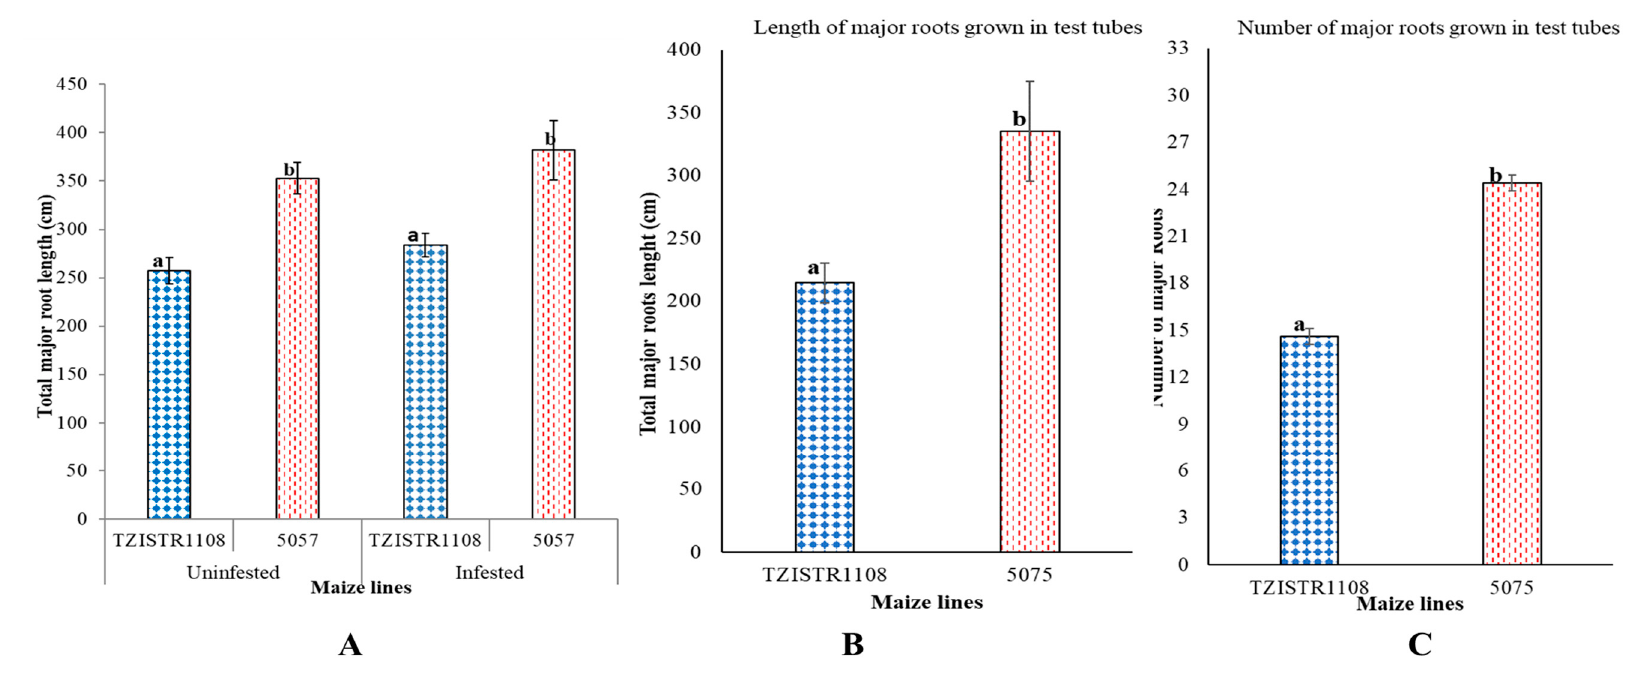
Figure 3. Root architecture evaluation. ( A ). Mean total length of major roots (infested and un ‐ infested) on both maize lines at 28 days after planting in pots. ( B ). Mean number of major roots at 53 days after planting in test tubes. ( C ). Mean total length of major roots at 53 days after planting in test tubes. The different letters (a and b) show significant differences among groups ( α = 0.05). The bars show standard error.